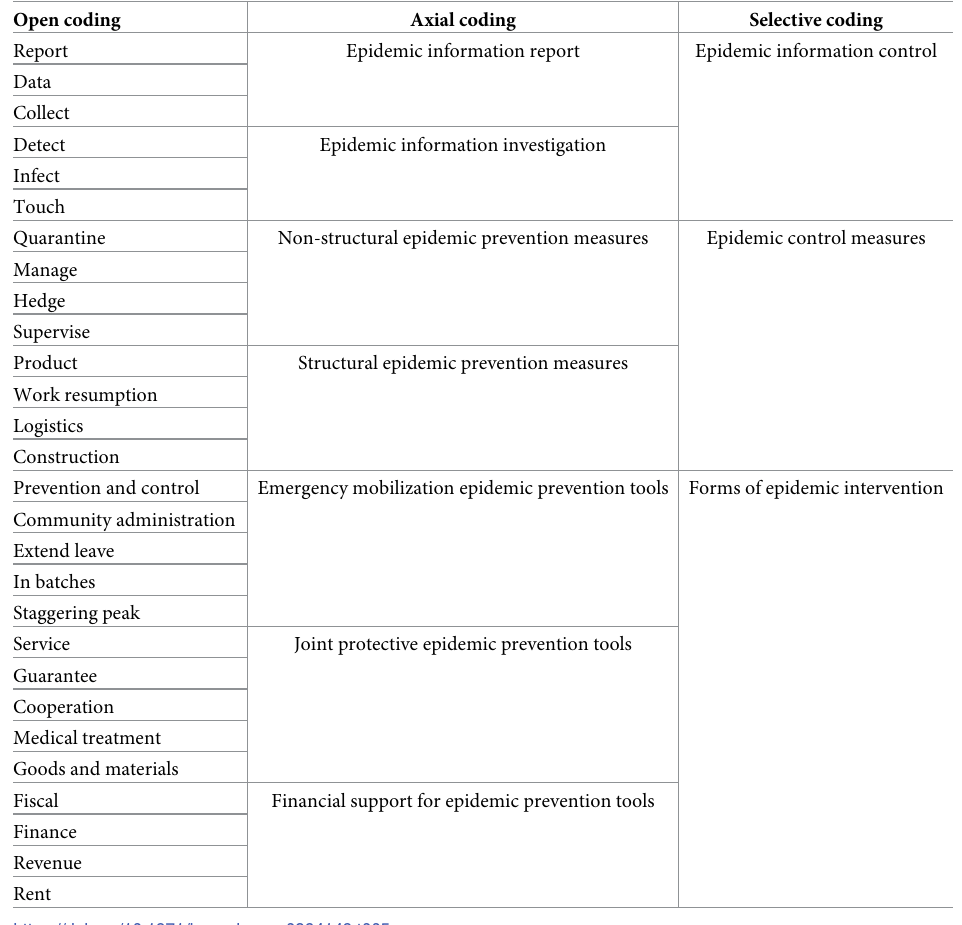
Table 5. Axial and selective coding of COVID-19 subject policy